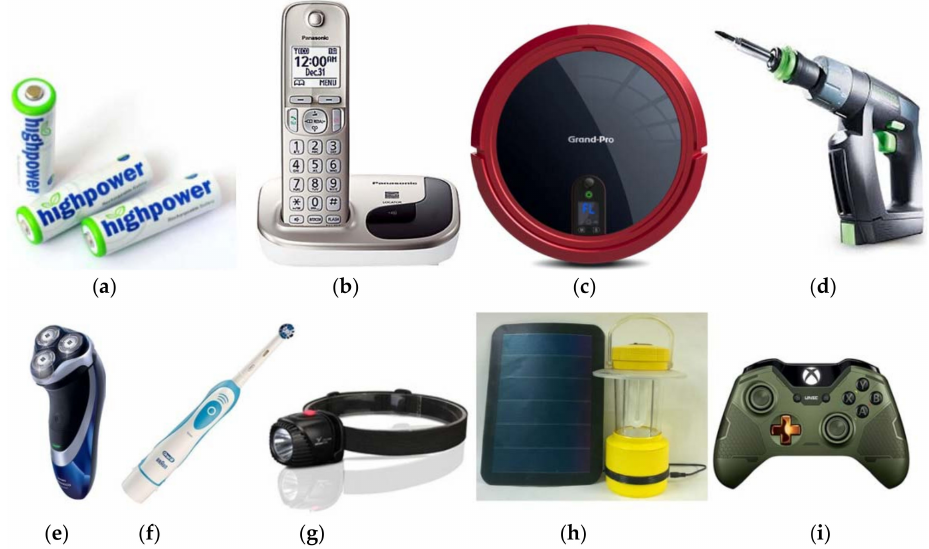
Figure 30. Examples of Ni/MH batteries in consumer applications: ( a ) retailer, ( b ) cordless phone, ( c ) vacuum cleaner, ( d ) power drill, ( e ) shaver, ( f ) toothbrush, ( g ) flashlight, ( h ) solar lamp, and ( i ) remote control for game